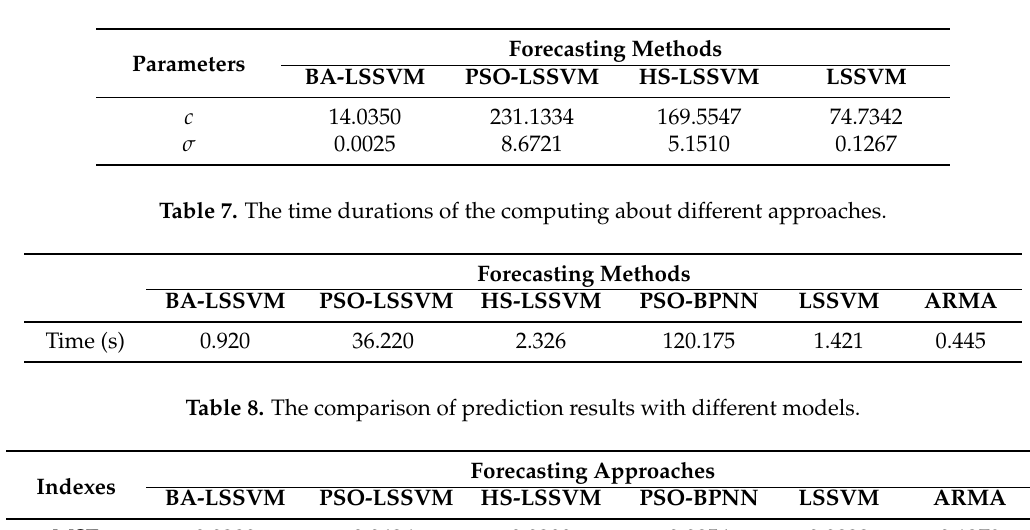
Table 6. The optimal parameters of LSSVM models.